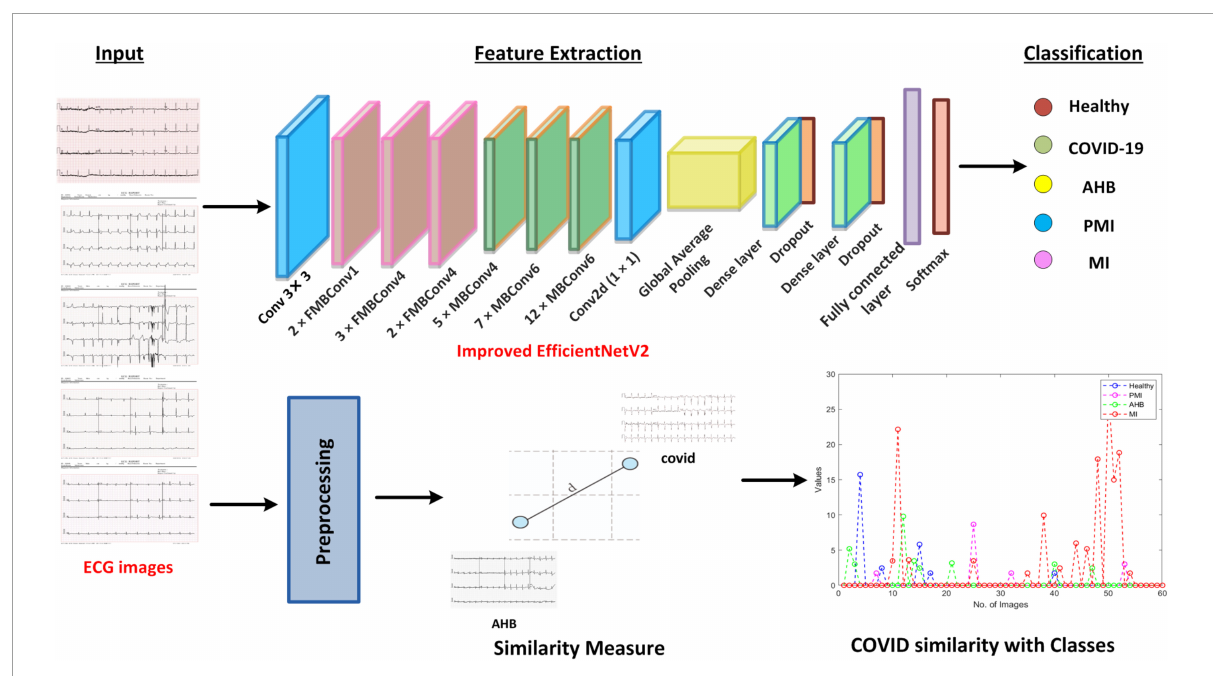
FIGURE1 Workflow diagram of ECG image-based COVID-19 classification using